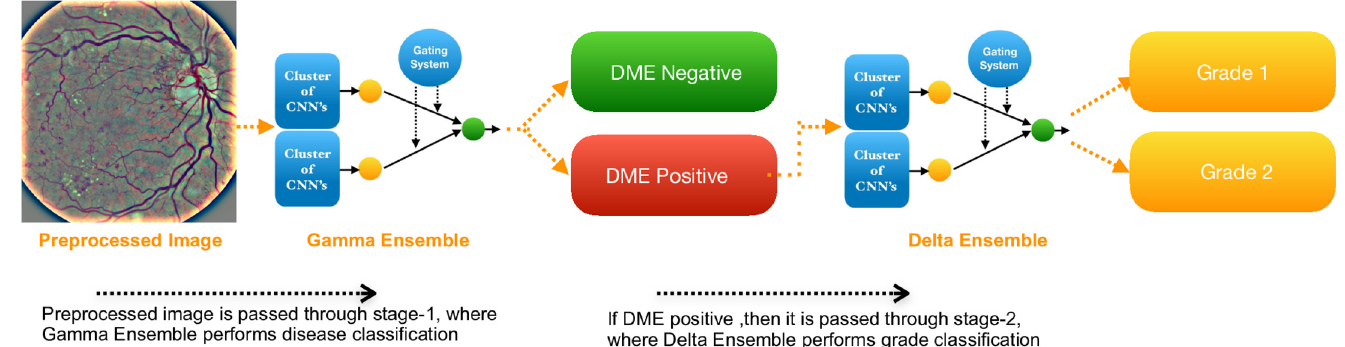
Fig 4. Illustration of the workflow of proposed model—DMENet. DMENet is a two-stage pipeline, where, in the first stage, the algorithm detects the presence/ absence of DME and once the presence of DME is confirmed it is passed through the second stage where the image is graded based on the severity.